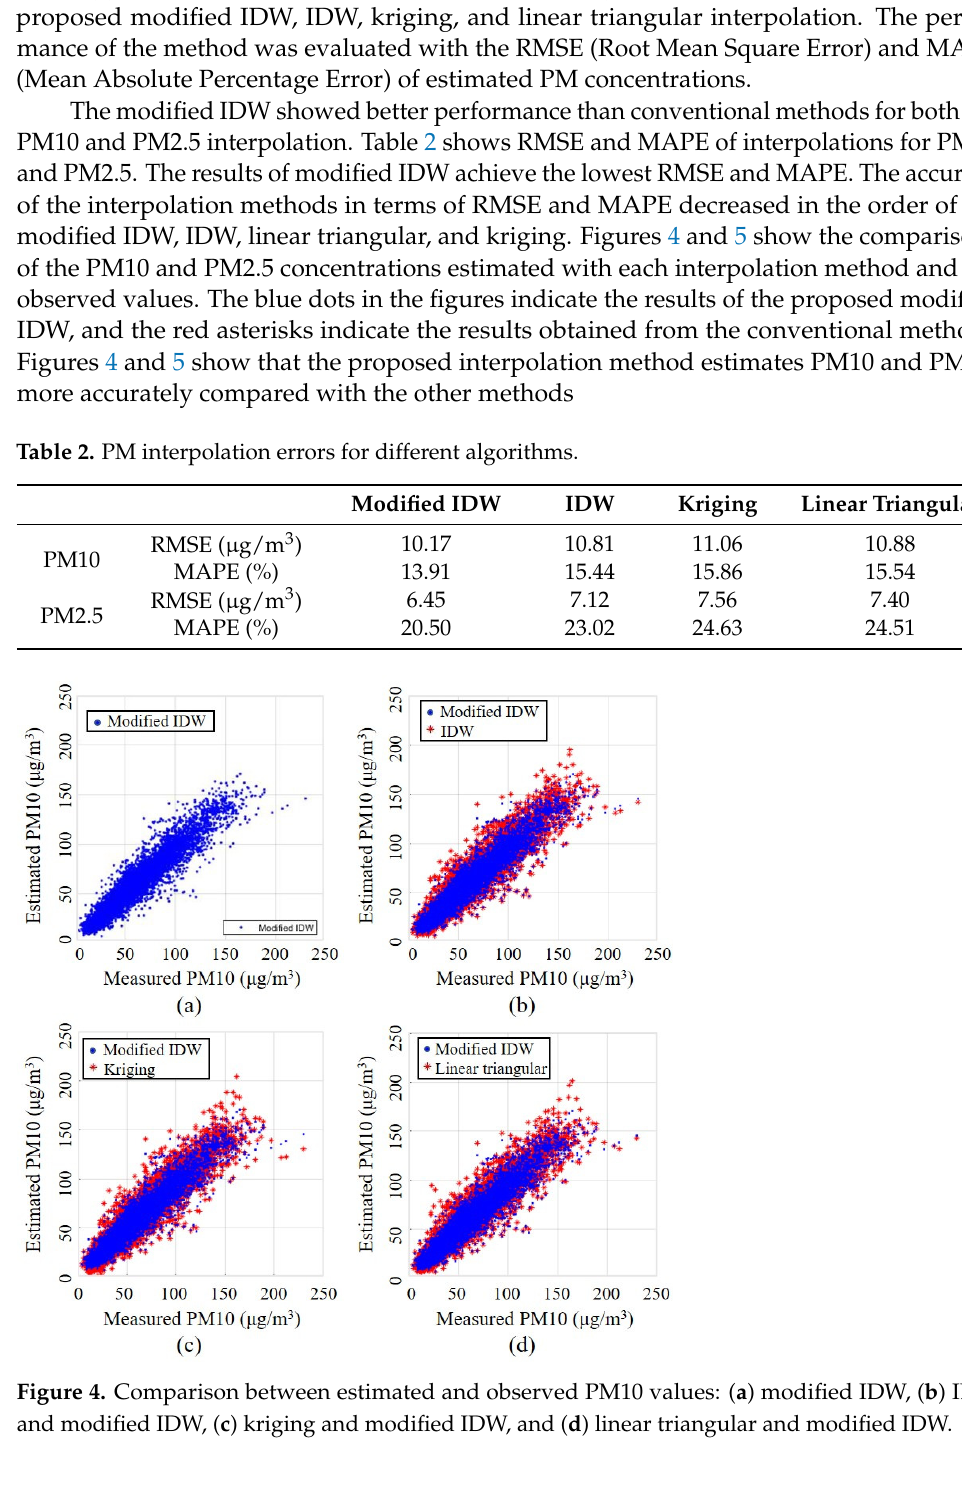
Figure 5. Comparison between estimated and observed PM2.5 values: ( a ) modified IDW, ( b ) IDW and modified IDW, ( c ) kriging and modified IDW, and ( d ) linear triangular and modified IDW. The performance of modified IDW was generally better than the conventional meth- ods for all AE groups. In particular, for groups of higher AE, the accuracy differences between the proposed and the conventional methods were increased. Figures 6 and 7